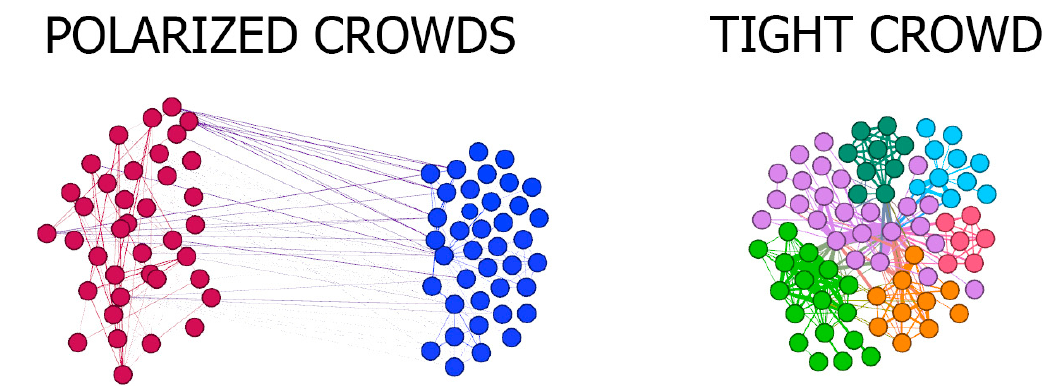
Figure 6. Basic communities of users on social networks. Adapted from: “Mapping Twitter Topic Networks: From Polarized Crowds to Community Clusters” [58].